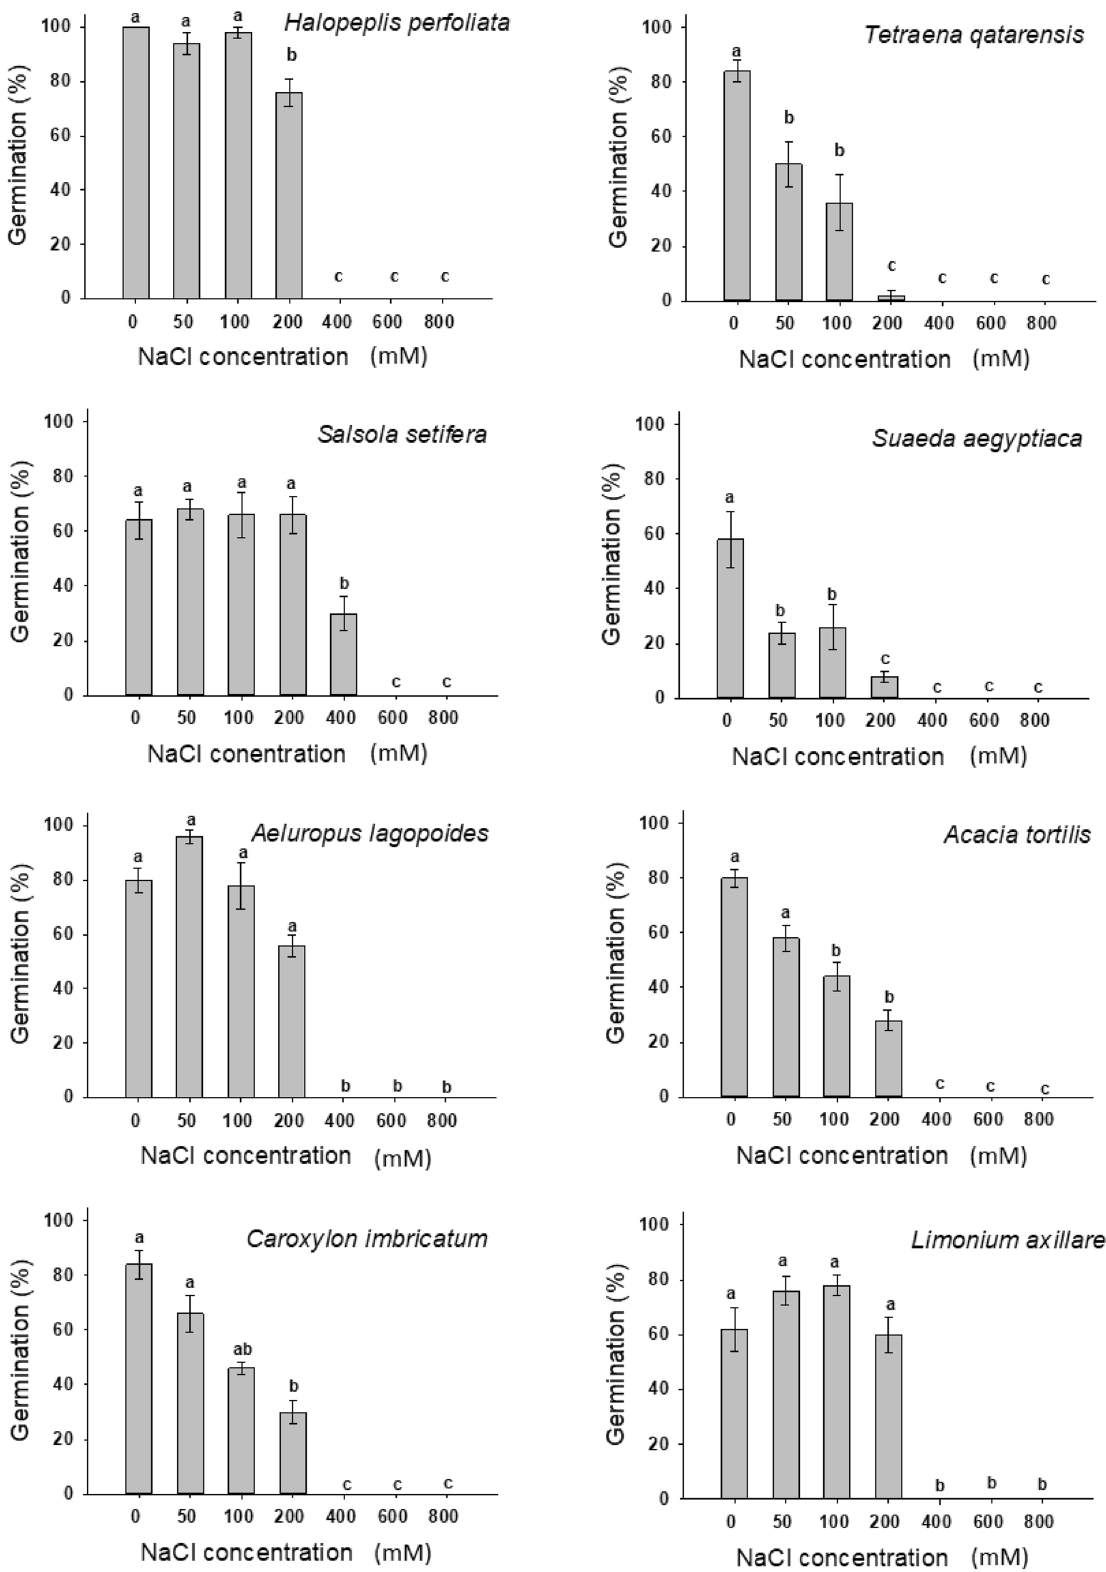
Figure 2. Cumulative percentage of seed germination of halophytes as dependent on NaCl concentration. Values shown are means ± SE. Values in a figure with a common letter are not significantly different according to Tukey’s test at p ≤